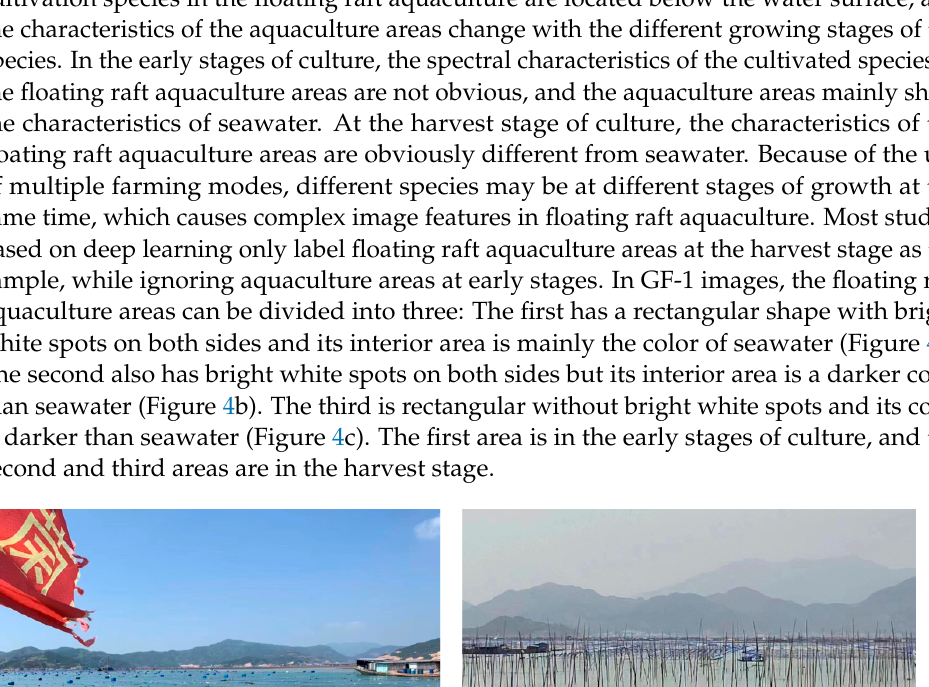
Figure 5. Cage aquaculture areas in GF-1. ( a ) The first type of cage aquaculture (imaged in Novem- ber 2013). ( b ) The second type of cage aquaculture (imaged in November 2017). ( c ) The third type of cage aquaculture (imaged in April